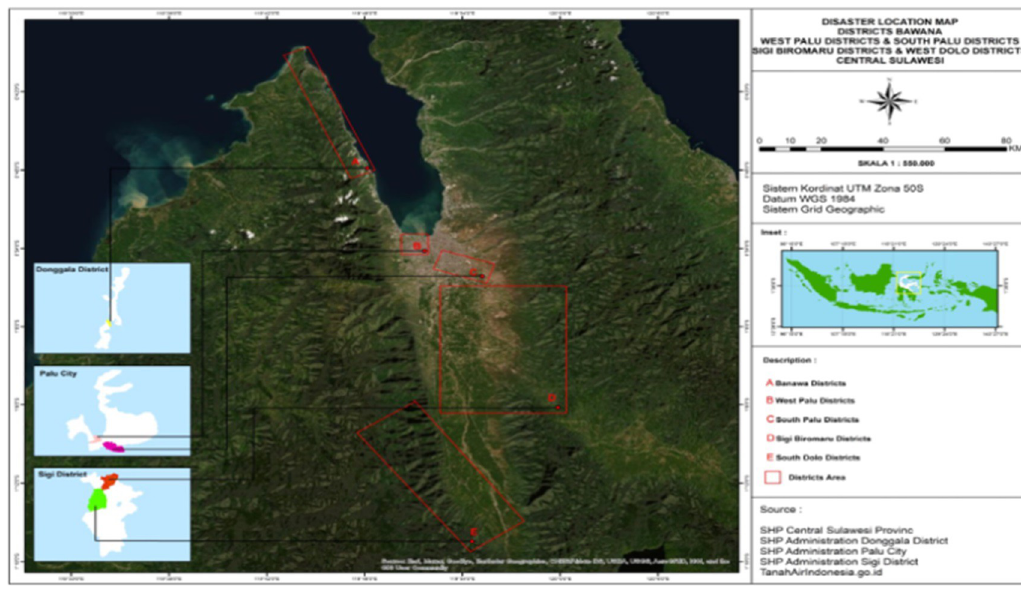
Fig 1. Map of research locations in Palu City, Sigi Regency & Donggala